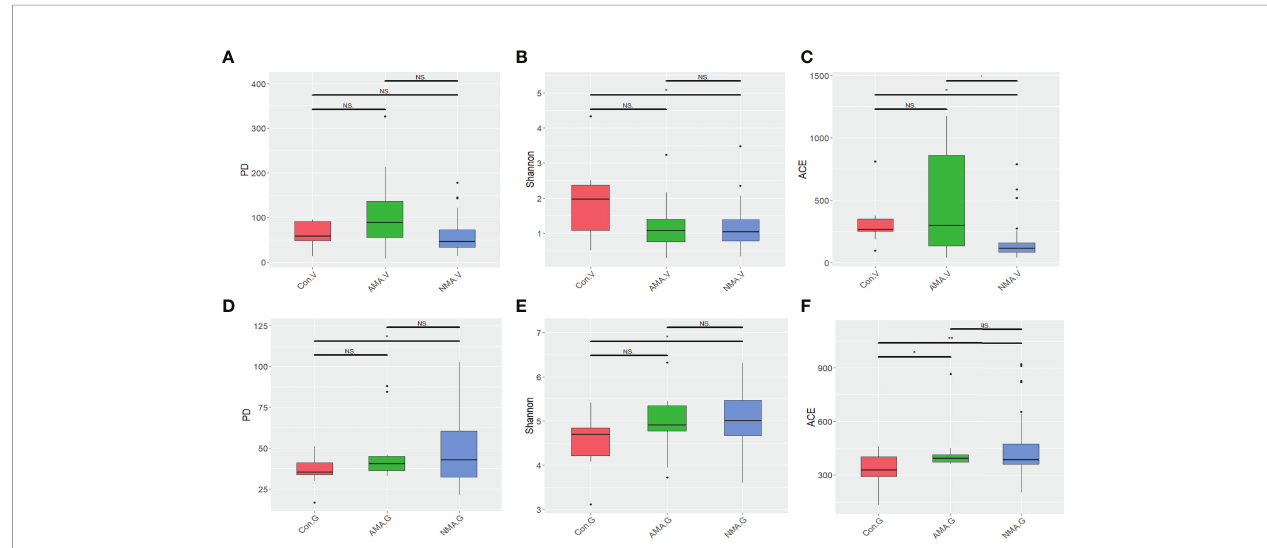
FIGURE 1 | (A – C) Alpha diversity index differences in vaginal microbiota between groups (Wilcoxon test). (D – F) Alpha diversity index differences in gut microbiota between groups (Wilcoxon test). NS, not statistically signi fi cant; * p < 0.05; ** p <